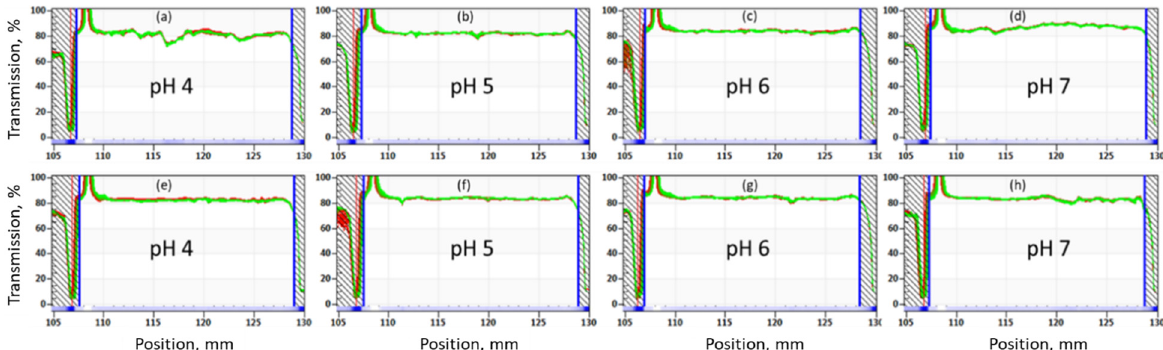
Figure 9. Accelerated stability analysis at 60 °C for 1 wt.% OF50-M in SSW at ( a , e ) pH 4, (b, f ) pH 5, (c, g ) pH 6, and ( d , h ) pH 7. The simulated stability duration was 6 months and runtime of experiment was 31 h. Samples were run in duplicate.